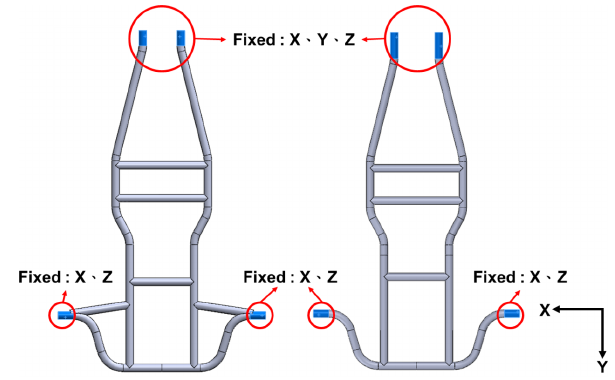
Table 8. Frame material parameters (SPFH590).